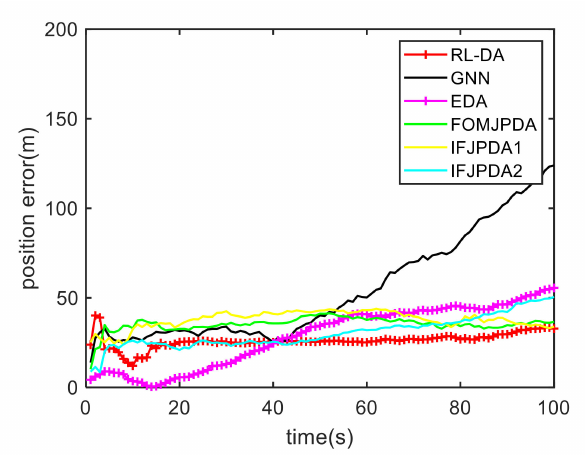
Figure 11. Comparison of the position errors for Target 2 in Case 2.